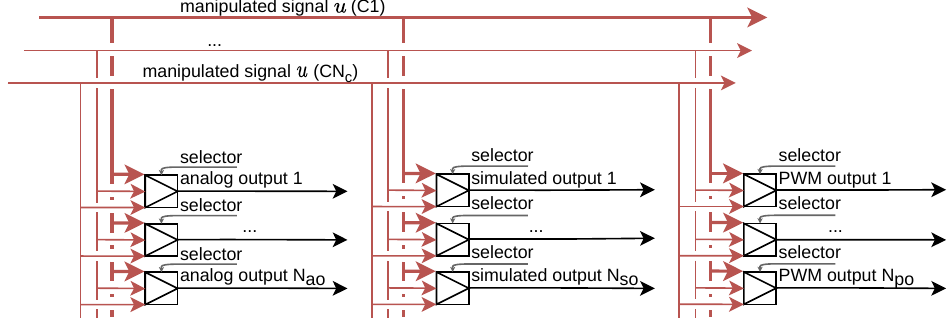
Figure 9. Selectors for output signals of the controller directing manipulated signal to one of many